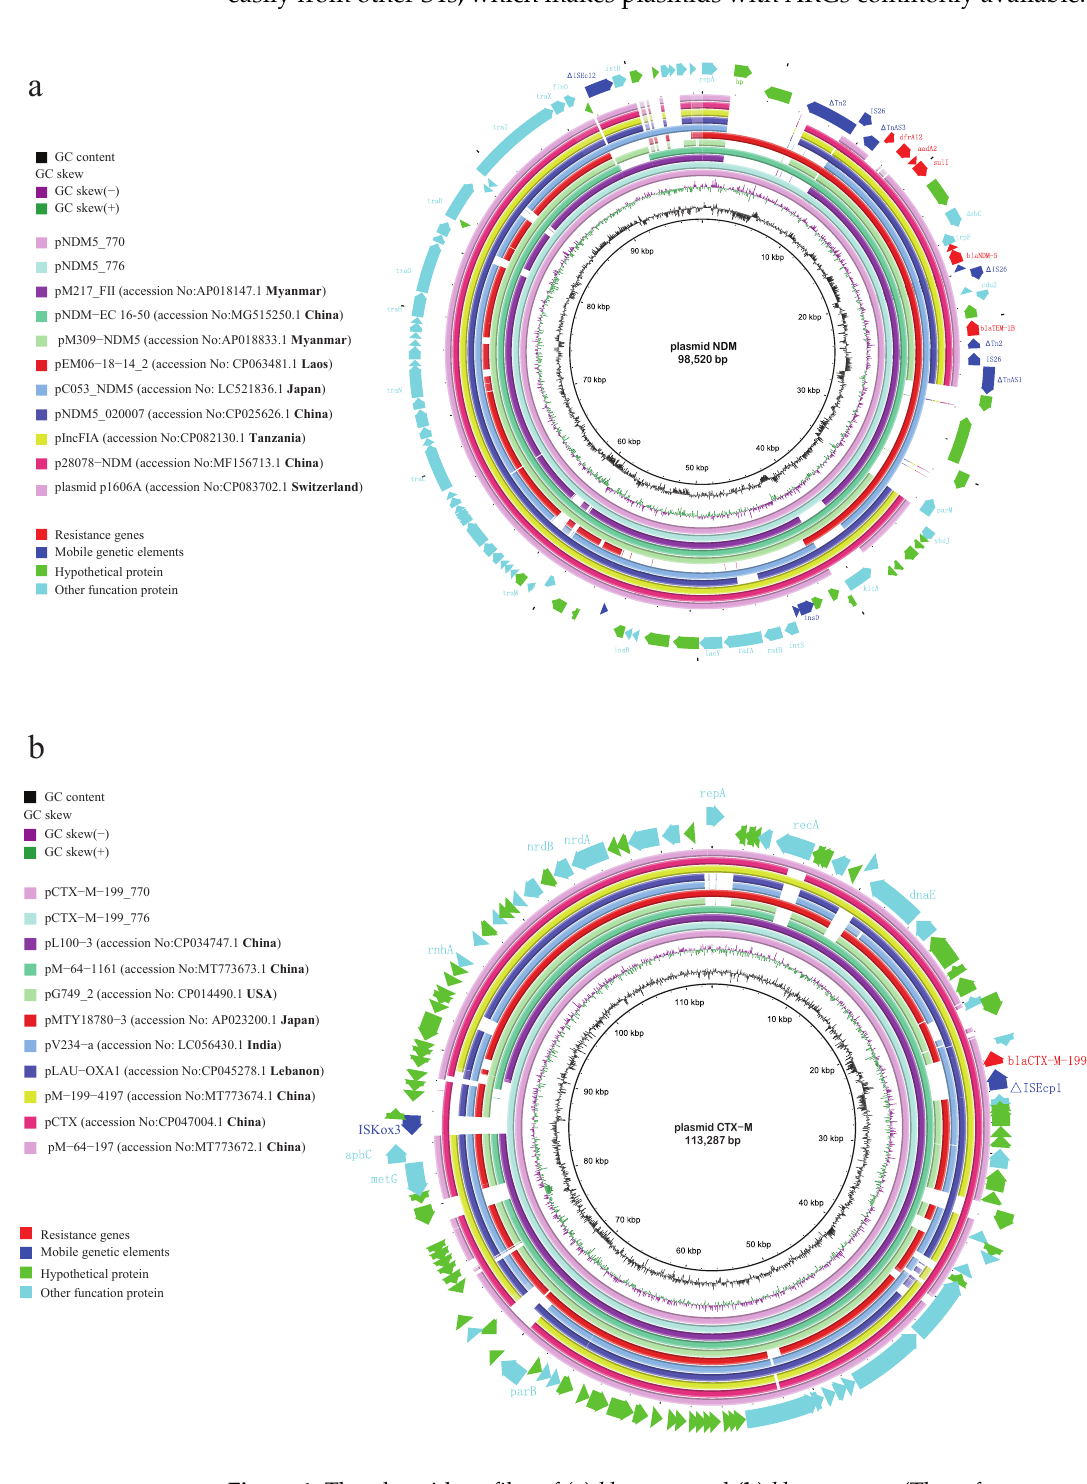
Figure 4. The plasmid profiles of ( a ) bla NDM-5 and ( b ) bla CTX-M-199 . (The reference sequences were bla NDM-5 - or bla CTX-M-199 -carrying plasmid of shared bikes. The shade of circles represents the number of identities, the blank means sequences were not consistent with the